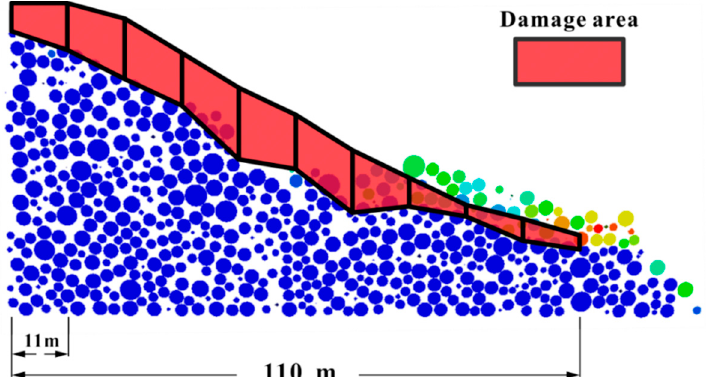
Figure 10. Comparison between modelled No. 3 gully and its field appearance.